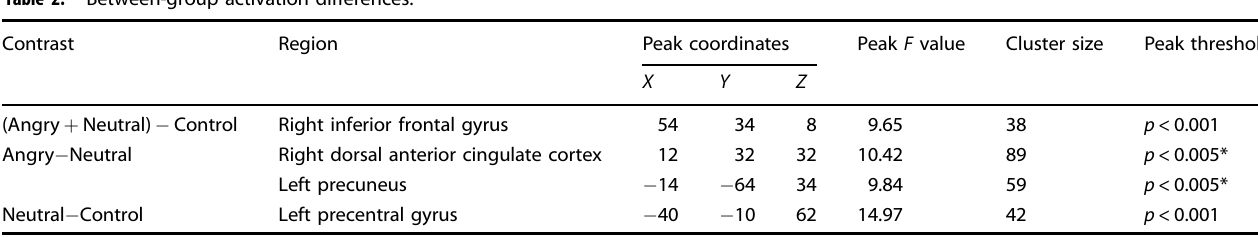
Table 2. Between-group activation differences.